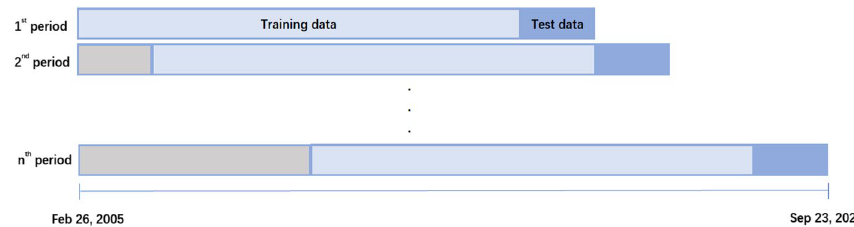
Fig. 10 Sliding window method for predicting the forward